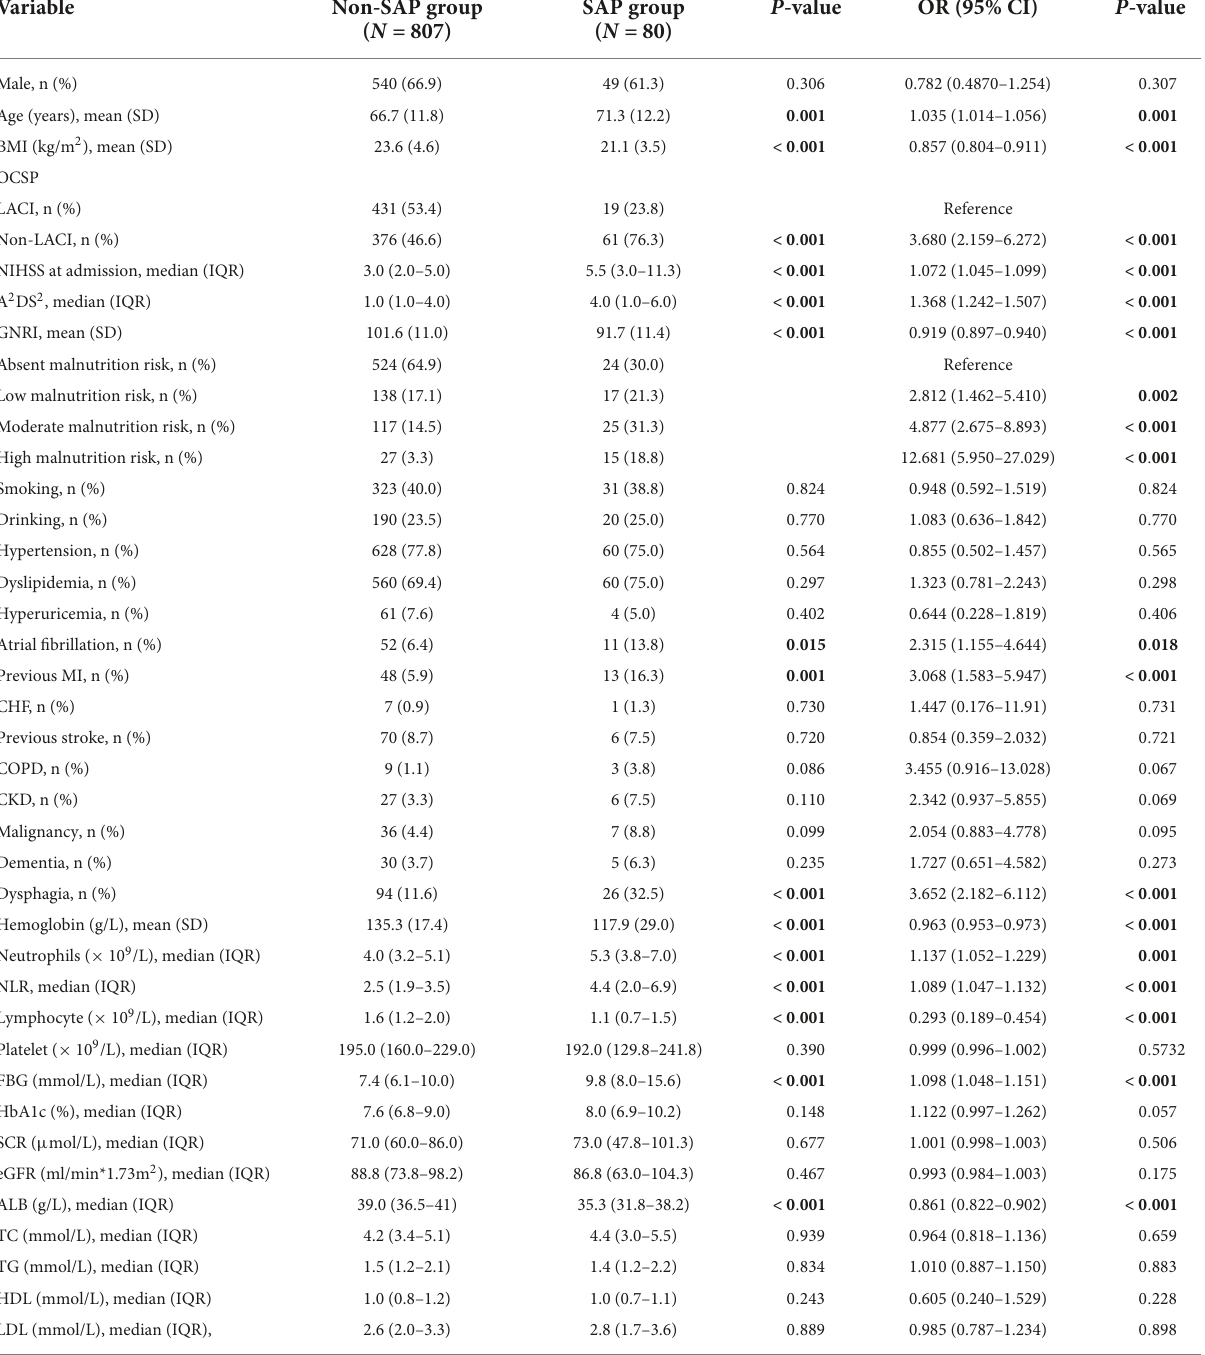
TABLE 2 Univariate regression analysis of SAP in the training